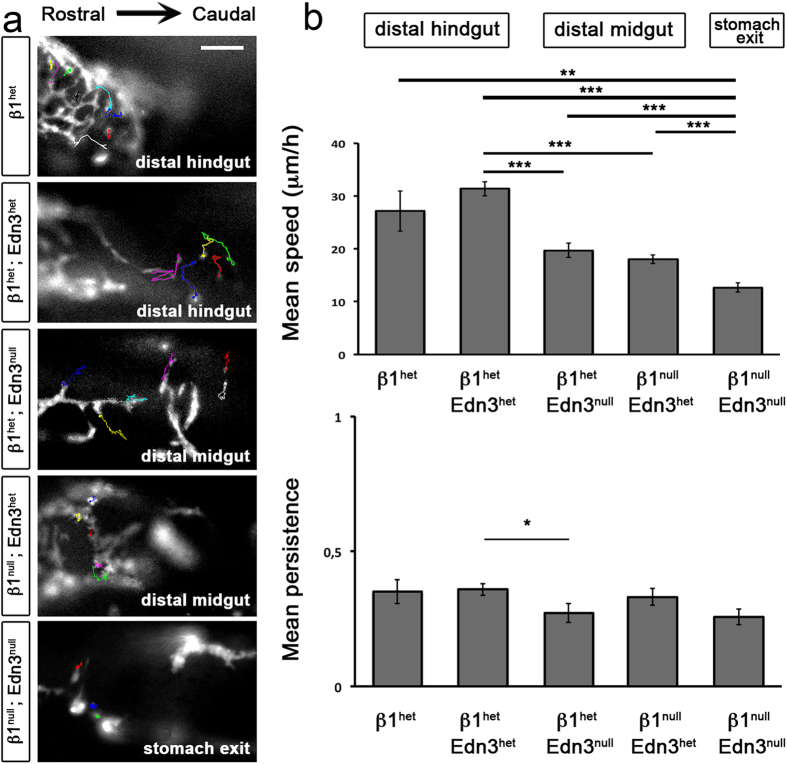
Migratory behaviour of ENCCs within the embryonic gut.(a) Images extracted from a representative time-lapse movie of E12.5–13.5 guts cultured ex-vivo from β1het (n = 3 guts); β1het; Edn3het (n = 7); β1het; Edn3null (n = 1); β1null; Edn3het (n = 5), and β1null; Edn3null (n = 3) genotypes, with examples of individual ENCC trajectories. Scale bar = 100 μm. (b) Graphs show the mean ENCC speed of migration depending on the gut genotype (upper graphs) and the mean persistence (lower graphs). The number of ENCCs analysed was: β1het n = 20; β1het;Edn3het n = 88; β1het;Edn3null n = 21; β1null;Edn3het n = 68 and β1null;Edn3null n = 37. Error bars indicate the SEM; *p < 0.05; **p < 0.01; ***p < 0.001.